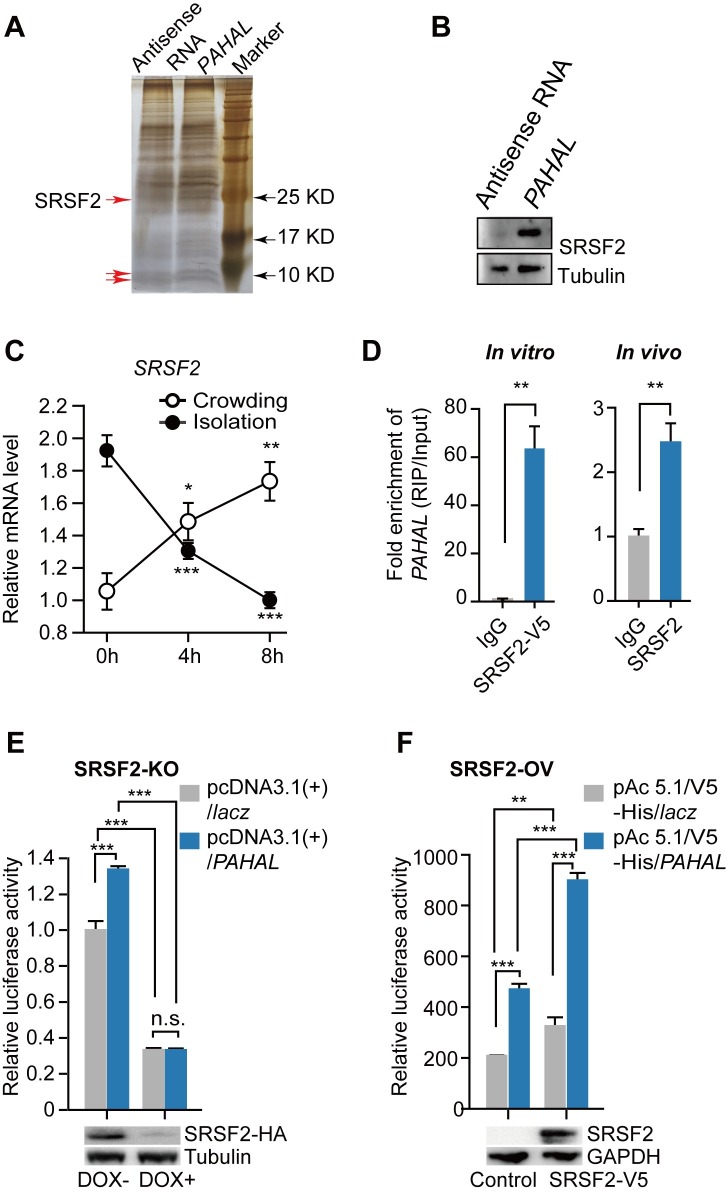
PAHAL activates PAH transcription by interacting with SRSF2.(A) RNA pulldown identifying PAHAL-associated proteins in the brain. Red arrows represent different protein bands between PAHAL and its antisense. (B) Western blot detects SRSF2 in protein pools from PAHAL RNA pulldown (N = 4). (C) SRSF2 expression in the brain during locust isolation and crowding. Eight replicates of eight brains were measured. (D) RNA immunoprecipitation (RIP) enrichment verifies that SRSF2 bound with PAHAL in vitro and in vivo. Five replicates of eight brains were measured. (E, F) SRSF2 facilitates the PAHAL-mediated transcription activation of PAH. Luciferase assays of P+5′-UTR were performed by using SRSF2 protein-depleted mouse embryonic fibroblasts (SRSF2-MEFs, SRSF2-KO). “DOX +” represents SRSF2 knockout, whereas “DOX–” indicates the normal expression of SRSF2 in SRSF2-MEFs or in either S2 cells overexpressed SRSF2 (S2, SRSF2-ov). Student’s t-test: *P < 0.05; **P < 0.01; ***P < 0.001; n.s., insignificant.